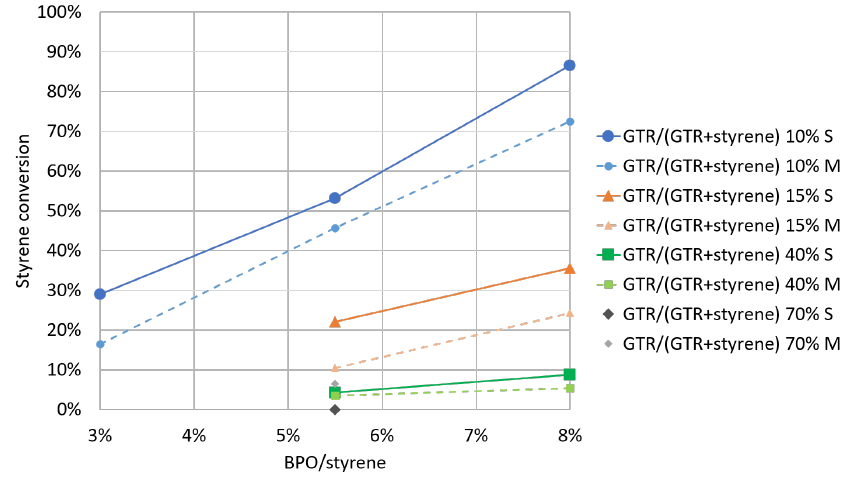
Figure 5. Comparison of small- (S) and medium- (M) sized systems at 90